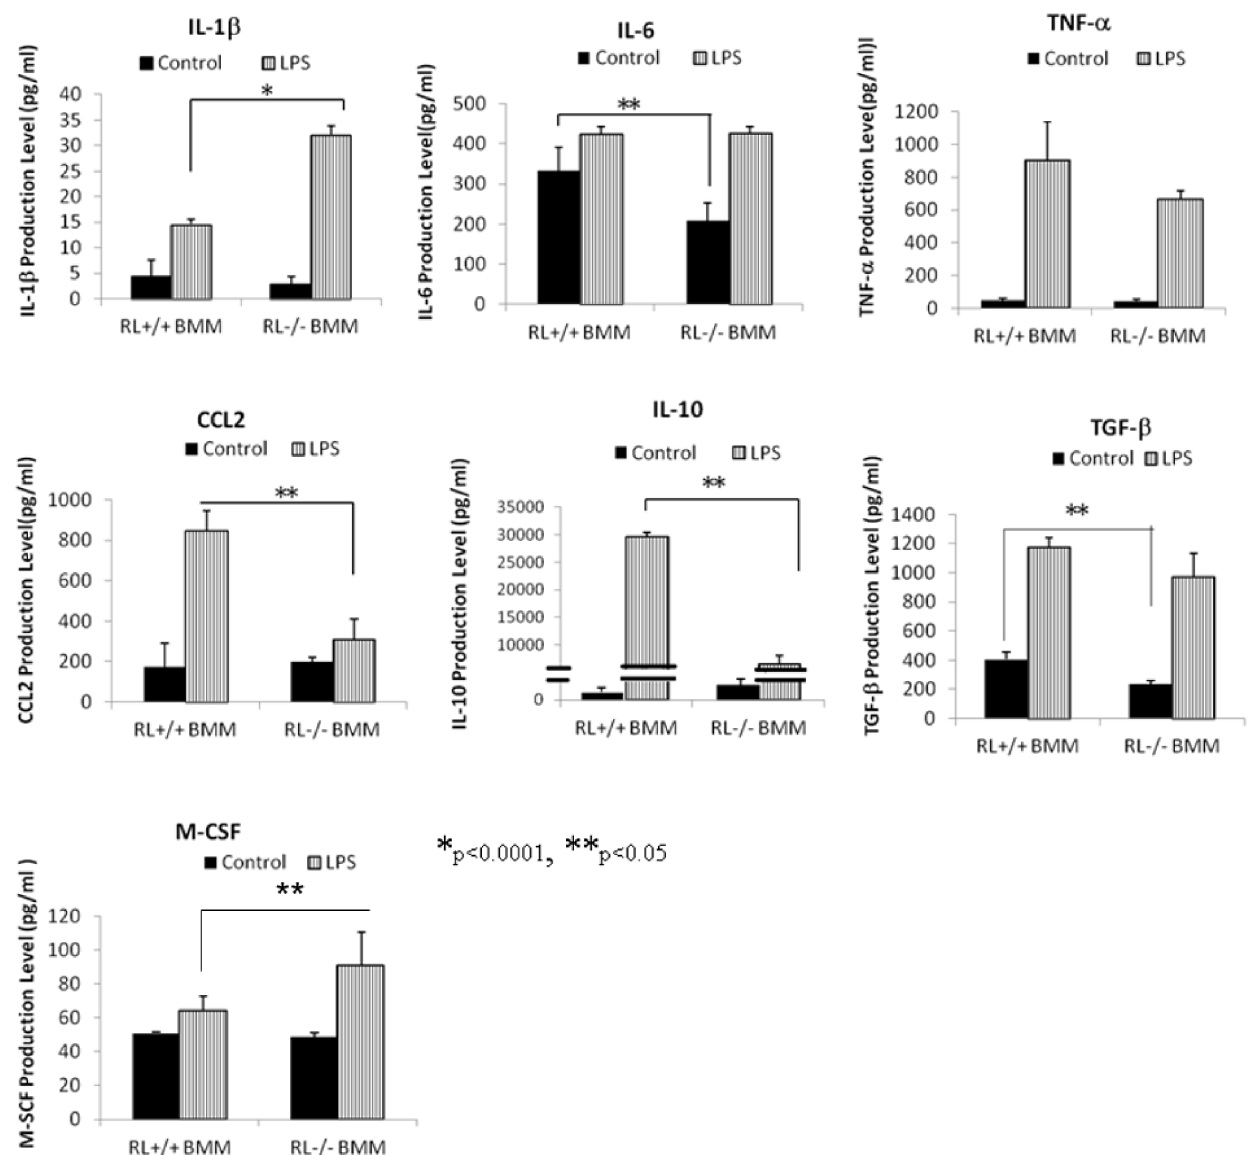
Figure 3. RNase L regulates the expression of cytokines and chemokines. RNase L deficient and wild type BMMs were treated with 1 m g/ml of LPS for 14 h. The secretory level of certain cytokines and chemokines in the media was measured by using an ELISA kit for each of the analyzers. Experiments were performed two times in triplicates. Data are presented as Mean 6 SD. *p , 0.0001, **p , 0.05.